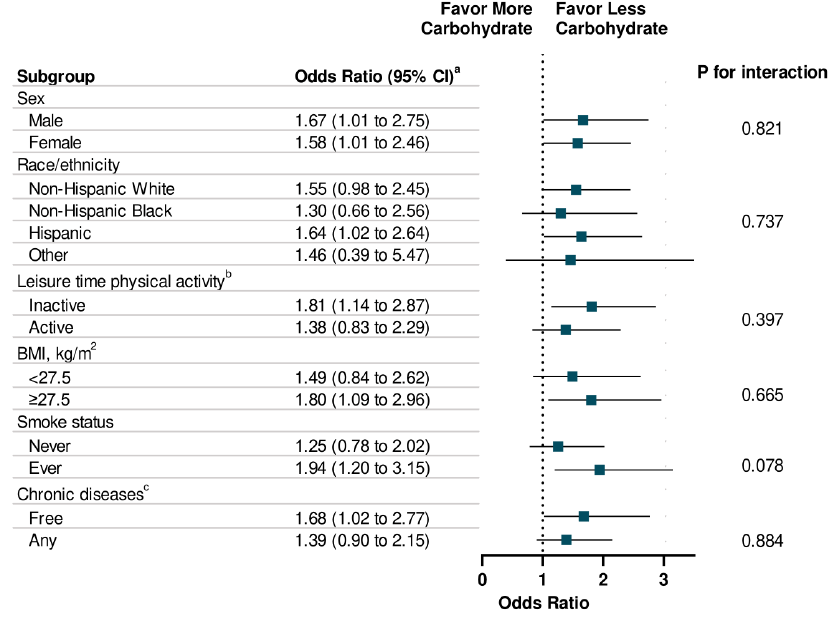
Figure 1. Stratification Analysis on Association Between Energy Intake from Carbohydrate and Memory Impairment Among US Adults ≥ 60 years, NHANES 2011–2014. a Multivariable models were adjusted for age, sex, race / ethnicity, education attainment, and family poverty ratio, physical activity, HEI-2010, alcohol intake, BMI, Body Weight, smoking status, hypertension, hypercholesterolemia, family